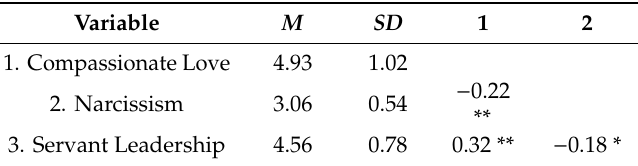
Table 2. Means, standard deviations, and correlations with confidence intervals.